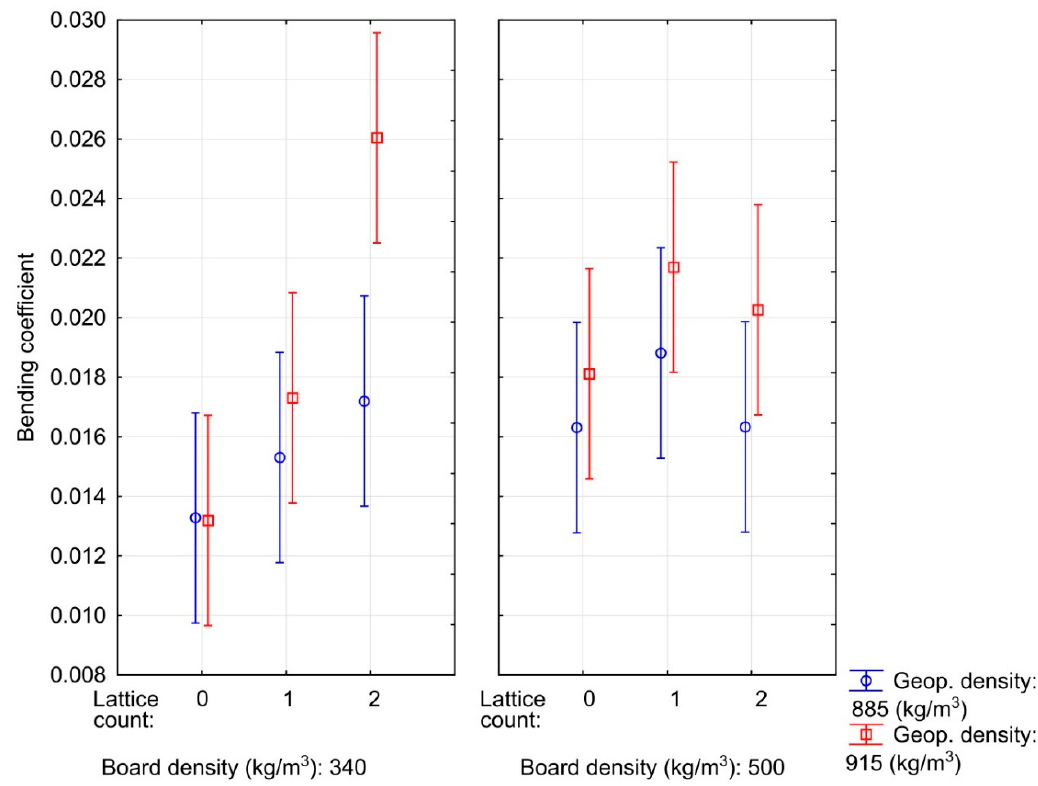
Figure 3. Influence of particleboard density, geopolymer density and the number of lattices on the modulus of elasticity of composite materials.